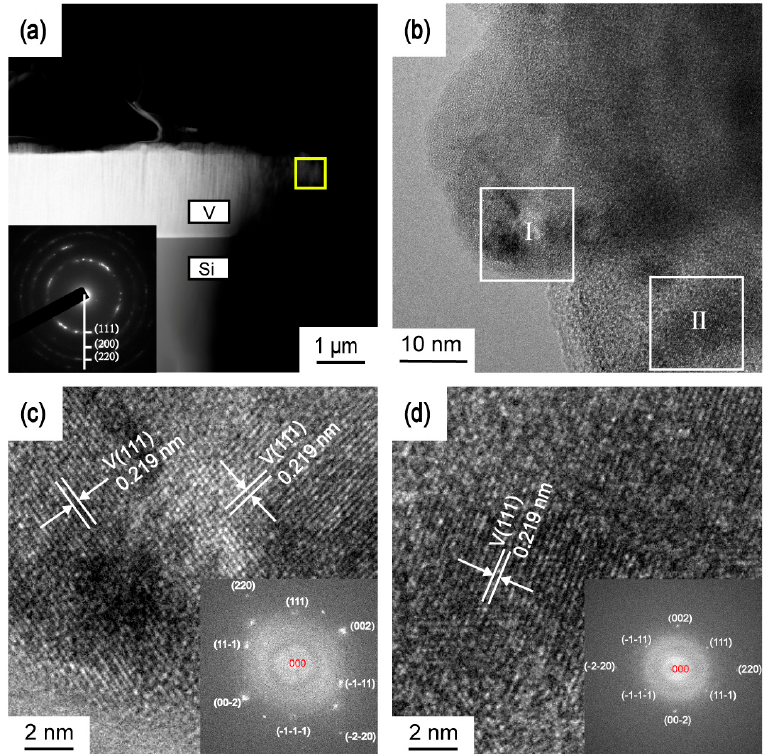
Figure 10. ( a ) Cross-sectional TEM image of the V film deposited on Si (100) at T s = 400 ◦ C and D t-s = 60 mm and SAED pattern of the yellow square area in insert, ( b ) TEM image of the yellow square area in ( a ), ( c ) HRTEM image and Fast Fourier Transform (FFT) of region I, ( d ) HRTEM image and Fast Fourier Transform (FFT) of region